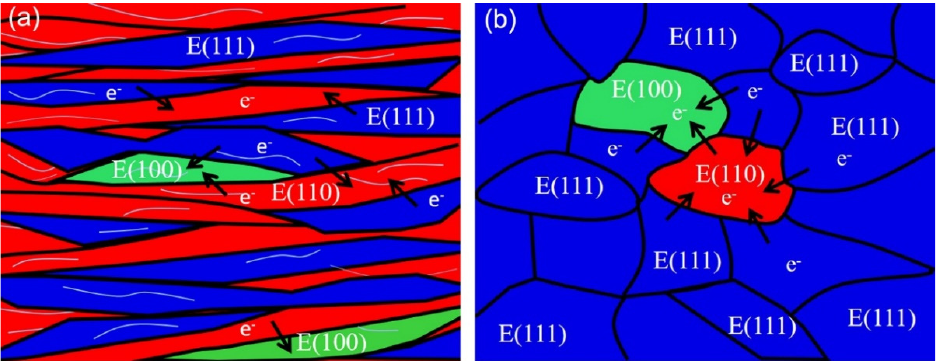
Figure 9. Schematic diagram of the effect of texture on the corrosion behavior of cold-rolled IF steel before and after